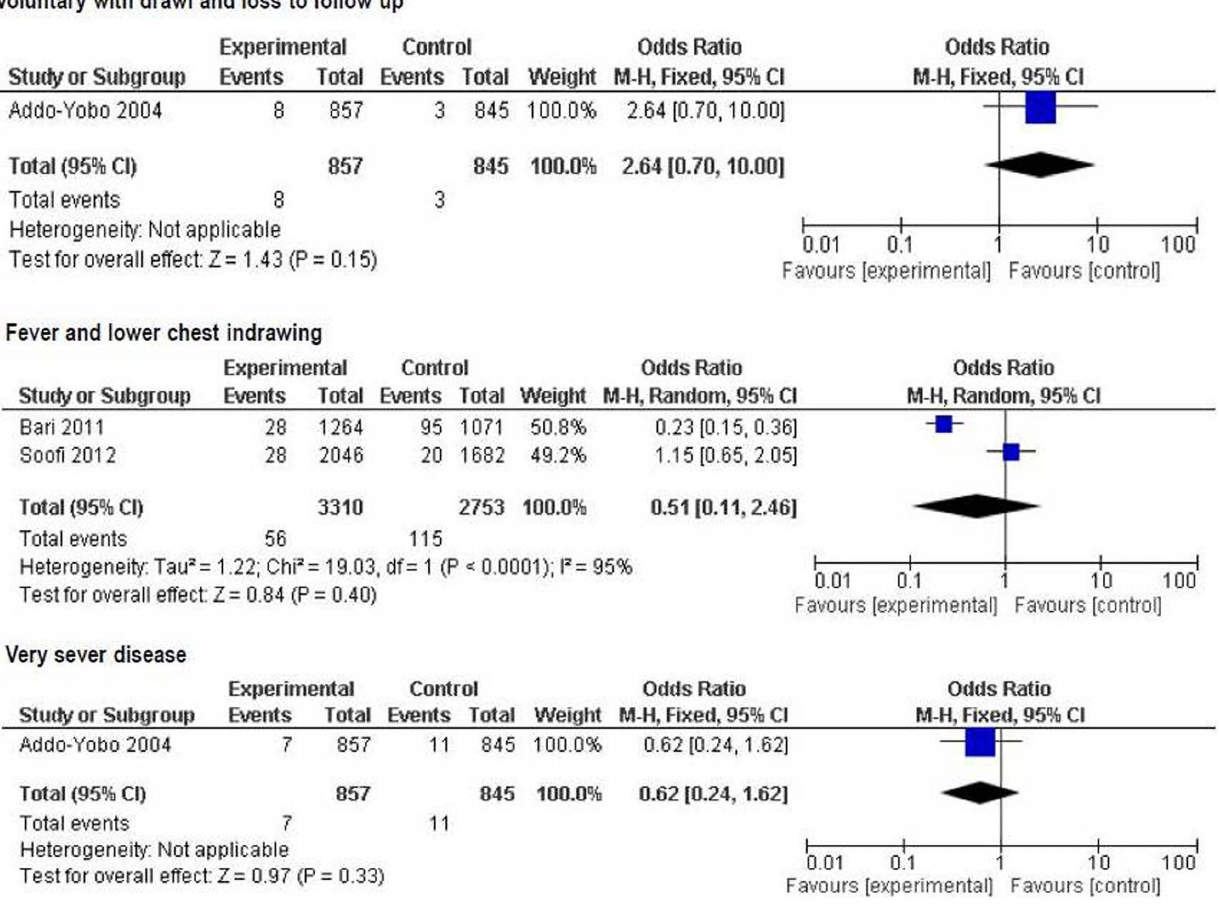
Figure 7. Secondary outcome measures: clinical predictors of treatment failure by 48 hr.